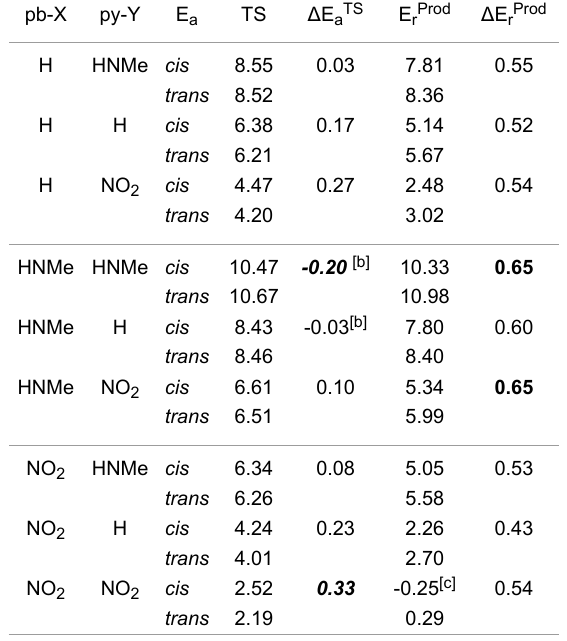
Table 1: Activation (E a ) and reaction energies (E r ) reflecting electronic differentiations in transition structures (ΔE a cis-trans ) and Pd-ene